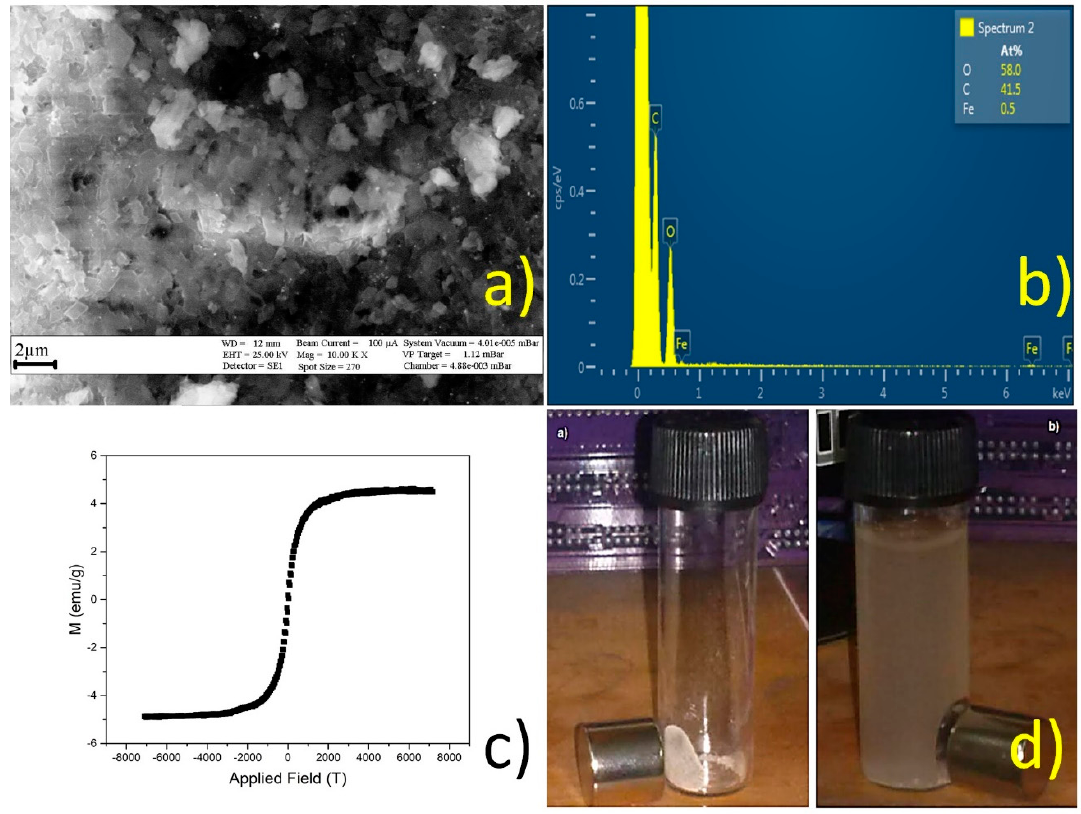
Figure 11. SEM ( a ); EDS ( b ); VSM ( c ); and magnetic response of nanosponges (NS) decorated with magnetite nanoparticles ( d ).